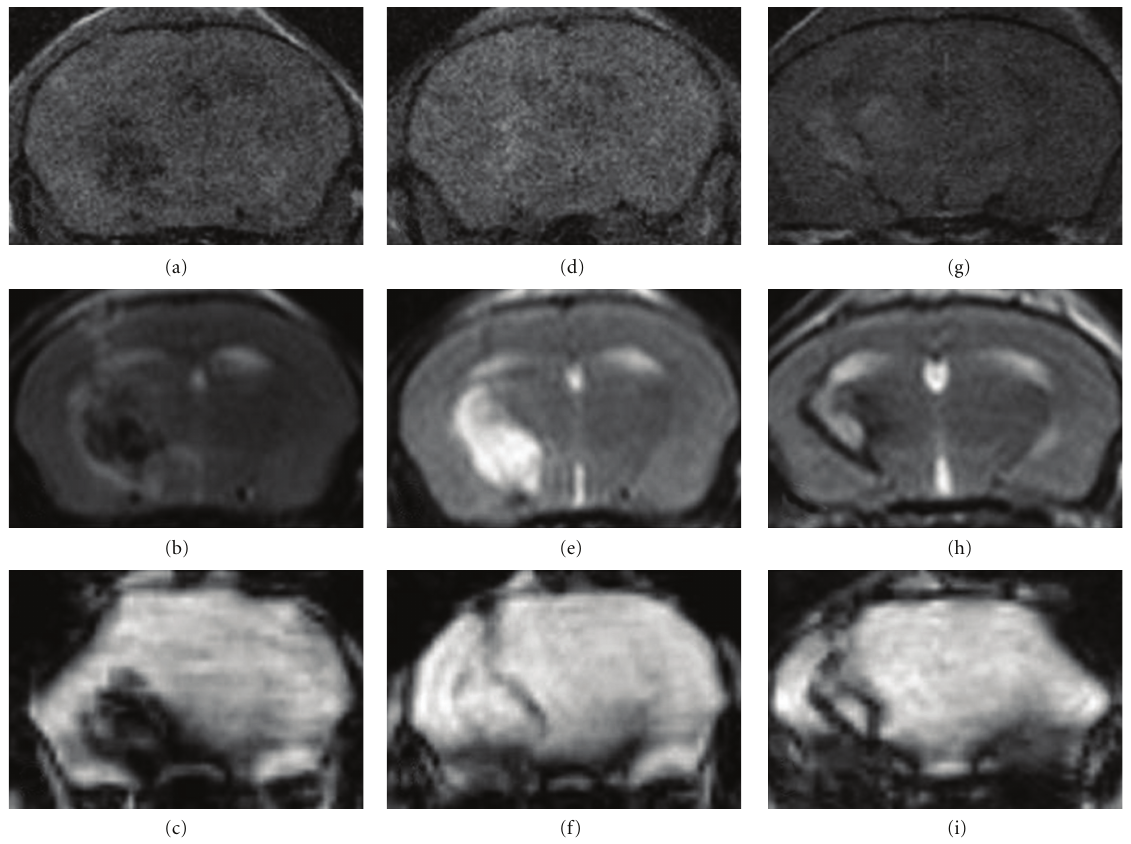
Figure 3: Temporal evolution of hematoma and edema after day 1 (a, b, and c), day 3 (d, e, and f), and day 10 (g, h, and i). On T1-weighted images, the hyperintense hematoma on day 1 (a) gradually changes to a hyperintense core over 10 days (c). On T2-weighted images, the core of the hematoma becomes hyperintense within 3 days (e) and develops a hypointense ring on day 10 (h) representing cavitation. The latter could also be discerned on T2 ∗ -weighted images on day 10